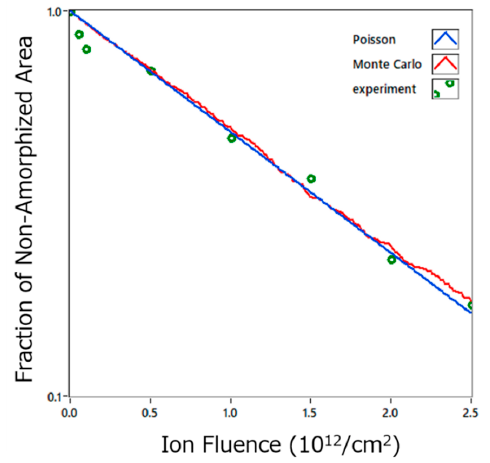
Figure 2. Fraction of non-amorphized area as a function of Xe ion fluence. Green circles, blue line, and red line represent the experimental result [21], result calculated by Equation (6) and the result from two-dimensional images, respectively. The logarithmic scale is used on the vertical axis.